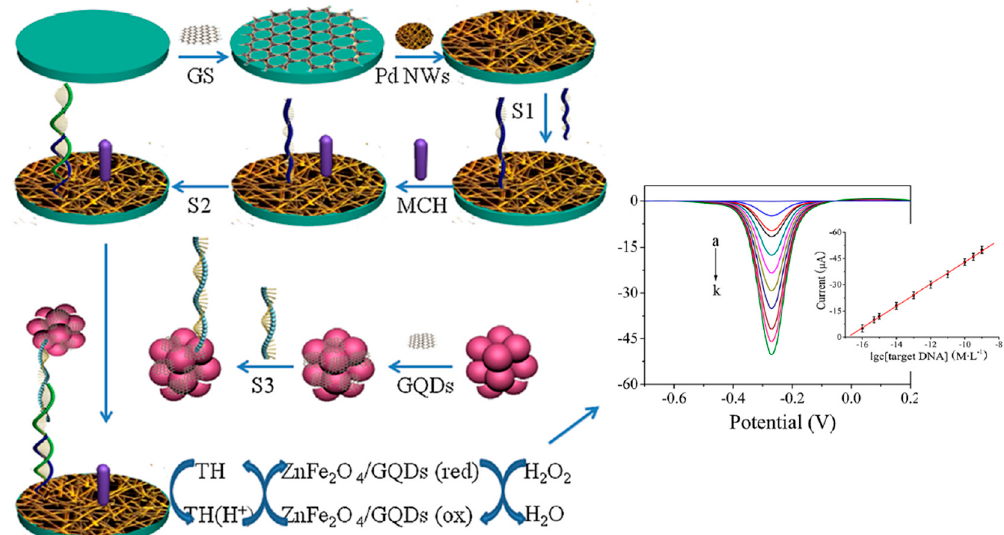
Figure 5. Schematic illustration of the electrochemical sandwich hybridization DNA sensor involving the use of ZnFe 2 O 4 /GQDs as a mimicking trace label and a nanocarrier of Dp (S3); real DPV responses of the DNA biosensor in the presence of different target DNA (S2) concentrations (0, 10 -16 , 5 × 10 -15 , 10 -15 , 10 -14 , 10 -13 , 10 -12 , 10 -11 , 10 -10 , 5 × 10 -10 , and 10 -9 M, a → k) and resulting calibration curve. Reproduced and adapted with permission from [45]. Copyright Elsevier,